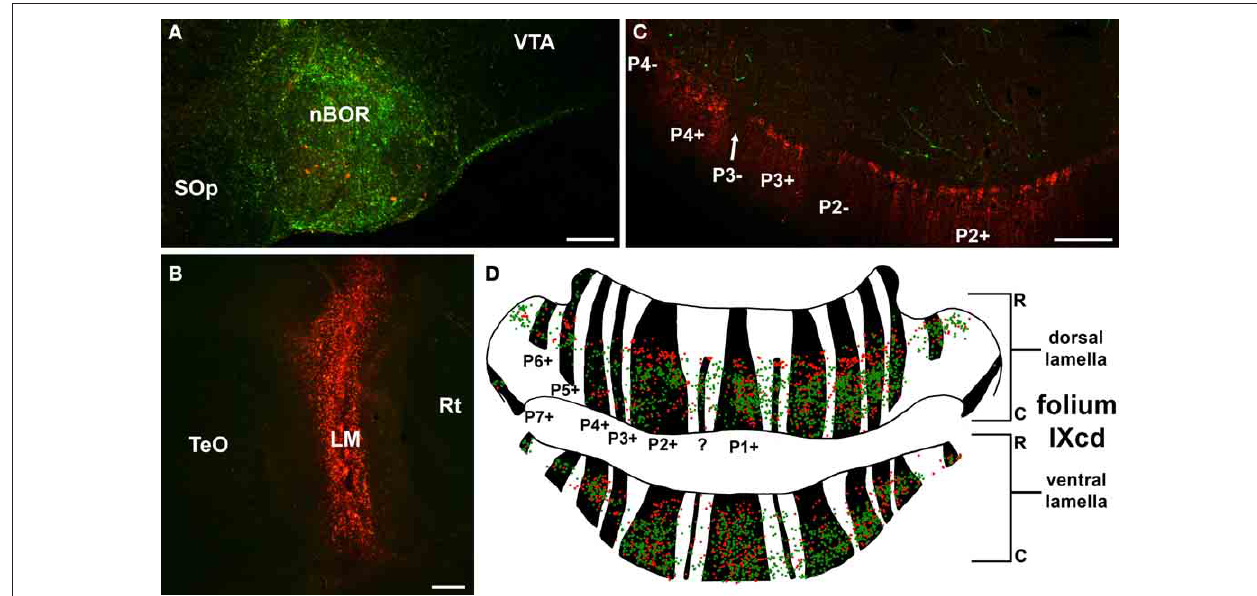
reconstruction of folium IXcd from serial sections. Each green and red dot represents a labeled terminal rosette from the injections in nBOR and LM, respectively, and the ZII + ve stripes are indicated in black. Note that most of the labeling is adjacent to the ZII + ve stripes. From Pakan et al. (2010). ?: Small immunopositive satellite band one to two Purkinje cells wide in the middle of P1 − ; Scale bars: (A,B) = 200 µ m; (C) = 100 µ